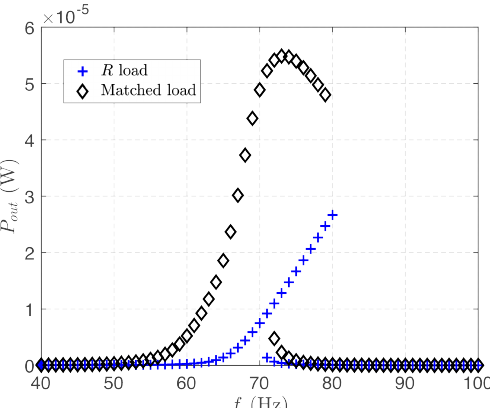
Figure 7. Average output power vs. forcing frequency for a nonlinear cantilever beam piezoelectric harvester [67]. Blue crosses are for the resistive load; black diamonds are for the matched